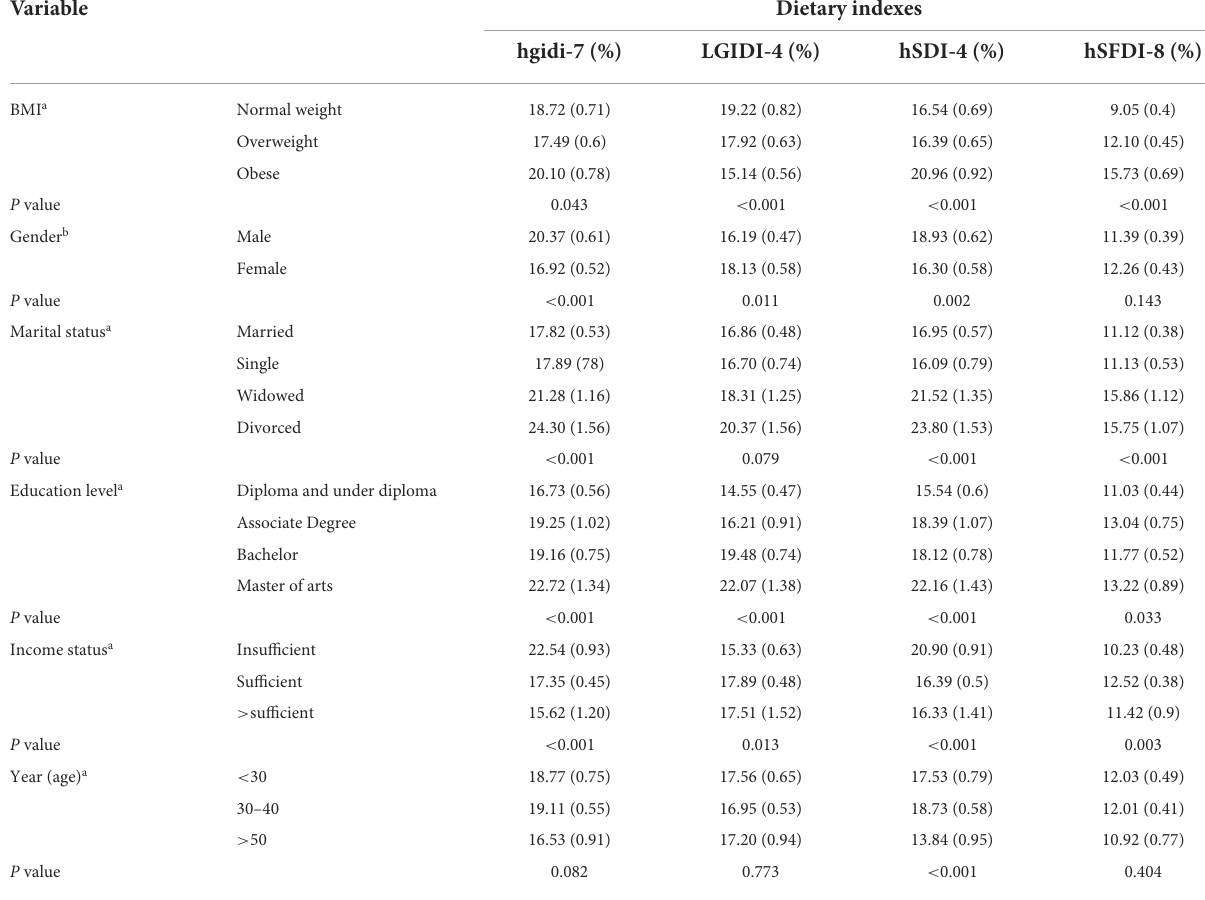
TABLE 4 Changes in dietary indexes (hSFDI-8, hSDI-4, LGIDI-4, hGIDI-7), at the levels of demographic variables.